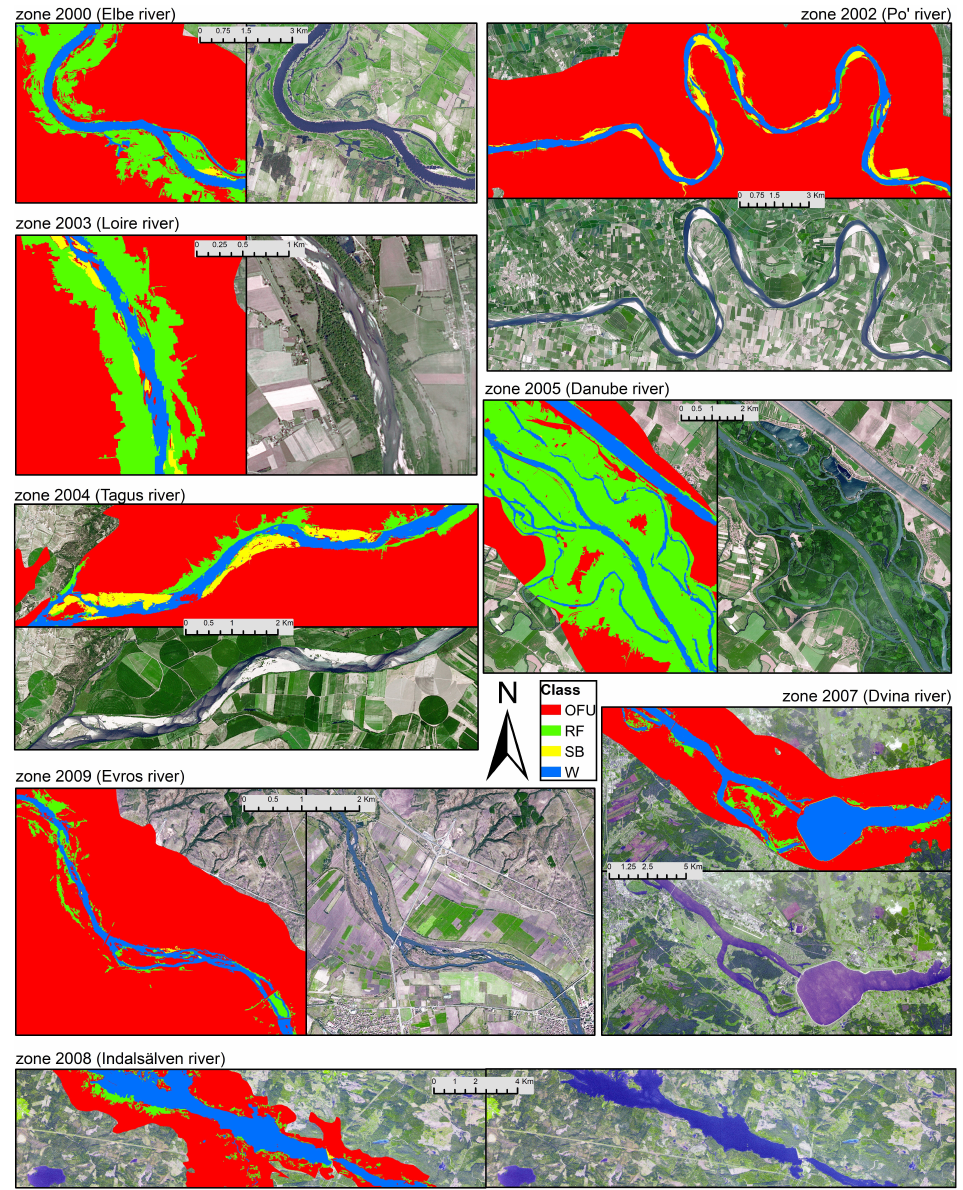
Figure 16. Examples of the classification map for di ff erent river types found around